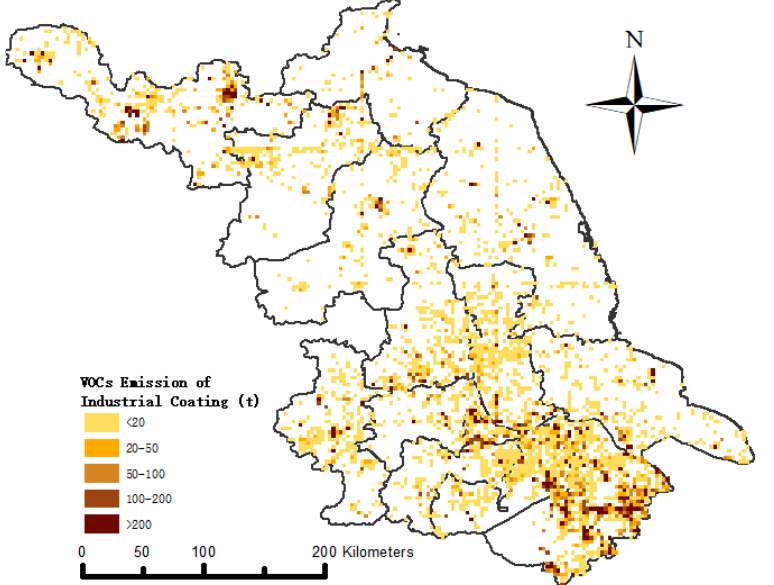
Figure 3. Spatial distributions of VOCs emissions for the surface-coating industries from point sources in Jiangsu Province for the year of 2020.